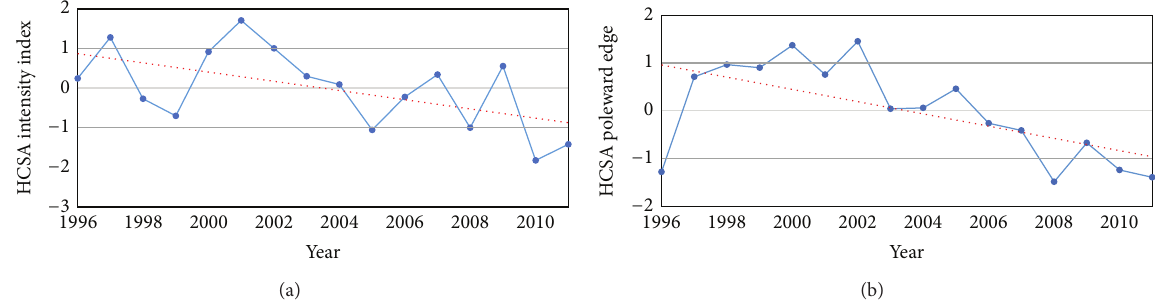
Figure 2: Normalized time series for the annual mean HCSA: (a) intensity index and (b) poleward edge in the period 1996–2011 with the linear trend (red dotted